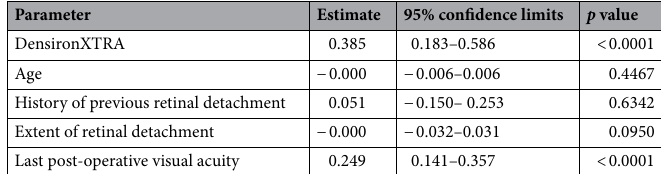
Table 3. Multivariable linear regression analysis results for visual acuity outcomes and their association with presence of DensironXTRA.